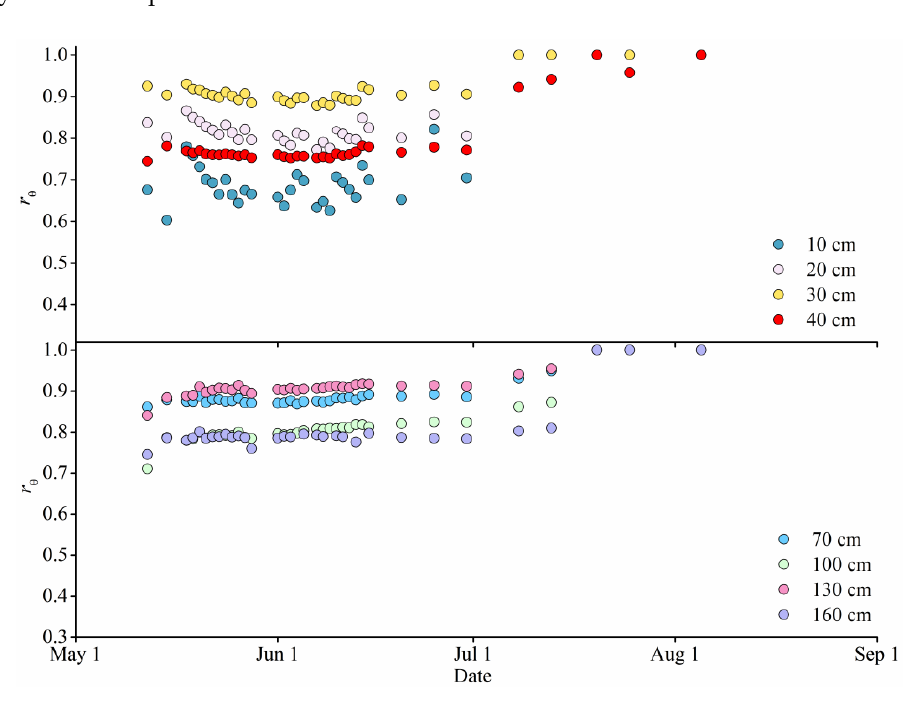
Figure 2. Seasonal variation of soil water availability ( r θ ) at different soil depths within the average growing space of the sample